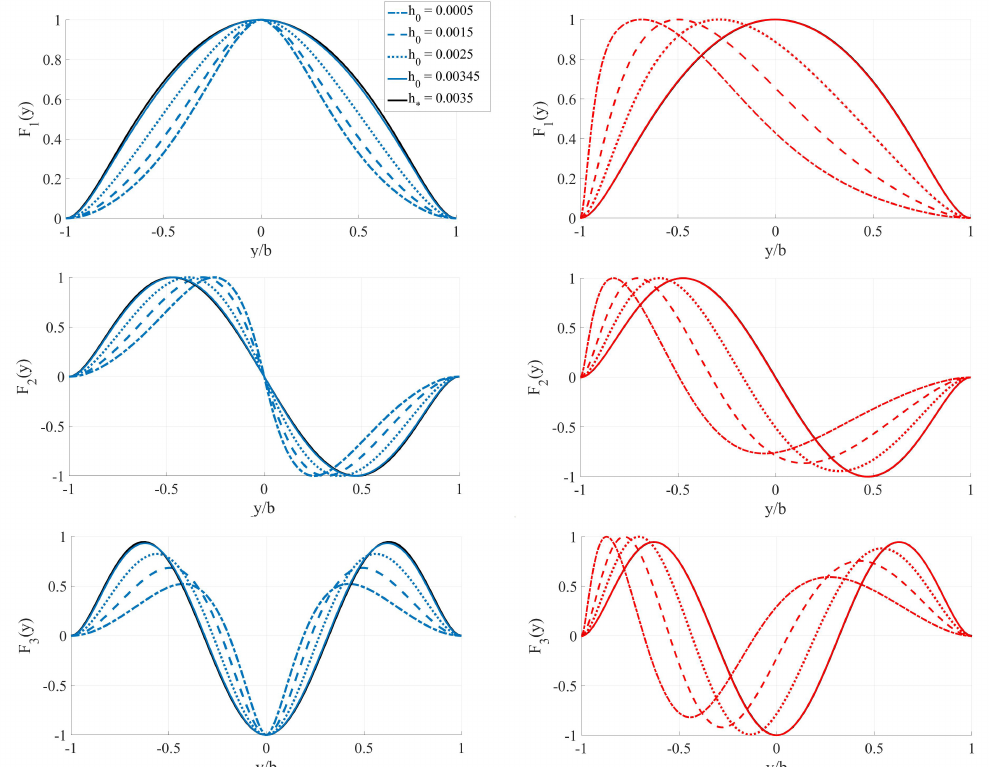
Figure 2. Profiles F n ( y ) of the first three hydroelastic modes across the channel for different values of h 0 and k = 3 m − 1 . Blue lines ( left column)—Case 1, red lines ( right column)—Case 2. Black lines show the results for the plate with constant thickness h ∗ (note that these line are covered by the solid colored lines for h 0 = 0.00345